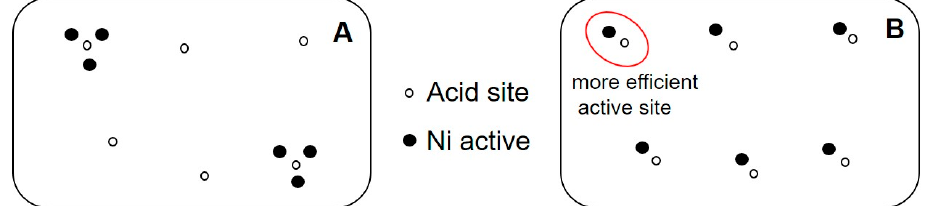
Figure 8. Match scheme of nickel and acid sites of ( A ) low nickel dispersed degree and ( B ) high nickel dispersed degree.